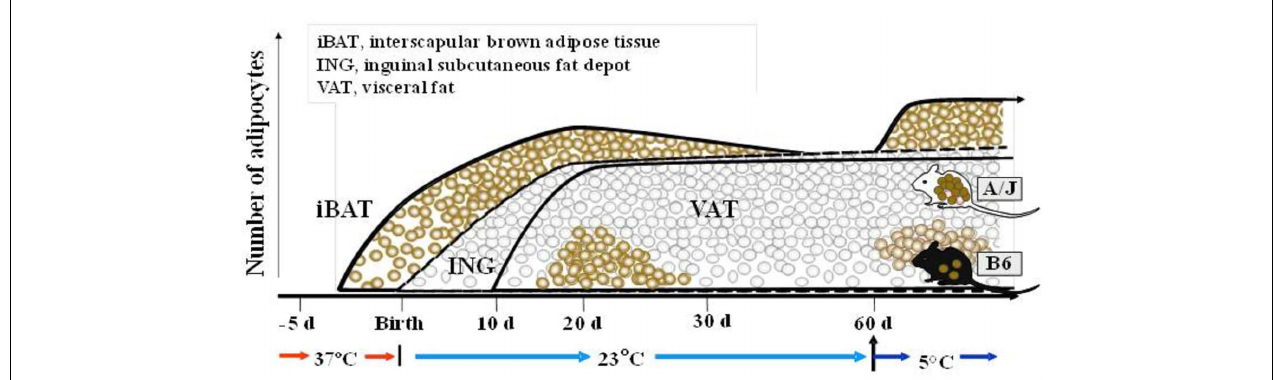
adipocyte at 20days of age is higher in A/J than C57Bl/6J (B6) mice, and is induced by in adult animals by adrenergic stimulation in A/J mice, but not B6 mice.This genetic difference in the induction of brown adipocytes among white fat depots is not found in iBAT.This figure has been modified from that found in Xue et al.